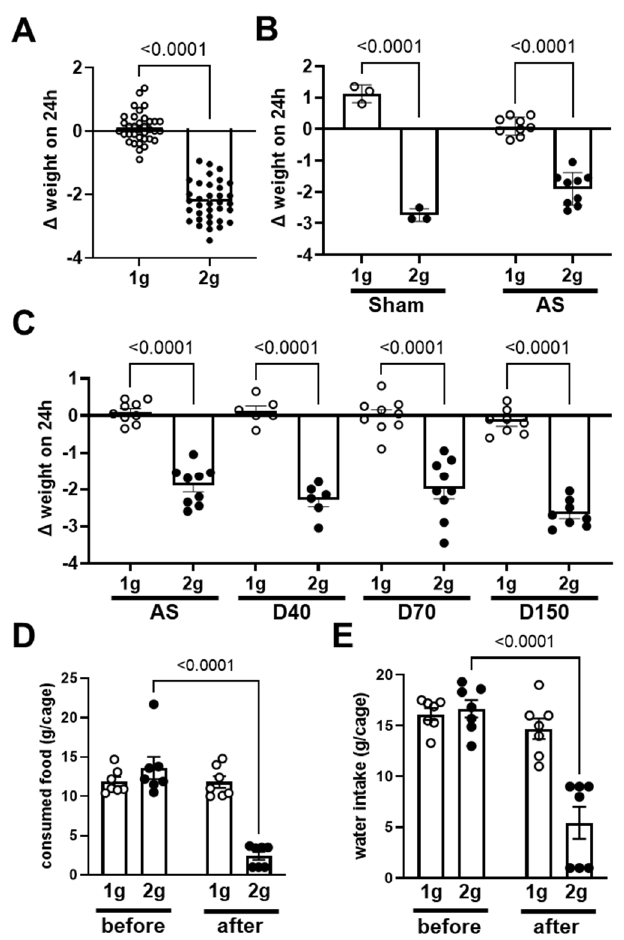
Figure 1. Variation in body weight and food and water consumption in normogravity and hypergravity. ( A ) Variation in body weight ( ∆ weight on 24 h expressed in grams) in 24 h in all mice exposed to both normogravity (1 g, circle) and hypergravity (2 g, point) conditions (n = 35 per condition). ( B ) Variation in body weight of mice injected with saline solution (Sham, n = 3 per condition, circle) and antisense oligonucleotide (AS, n = 9 per condition, point). ( C ) Variation in body weight of mice injected with antisense oligonucleotide (AS, n = 9 per condition), dextrans D40 (n = 6 per condition), D70 (n = 9 per condition) and D150 (n = 8 per condition). p values < 0.05 are precise. ( D ) Food and ( E ) water consumption during the 24 h; before the centrifugation (before) and after the period of centrifugation (after) in both 2× g and in 1 g groups. The consumption of food and water are expressed in g per cage, each cage containing three mice (n = 7 cages per group).